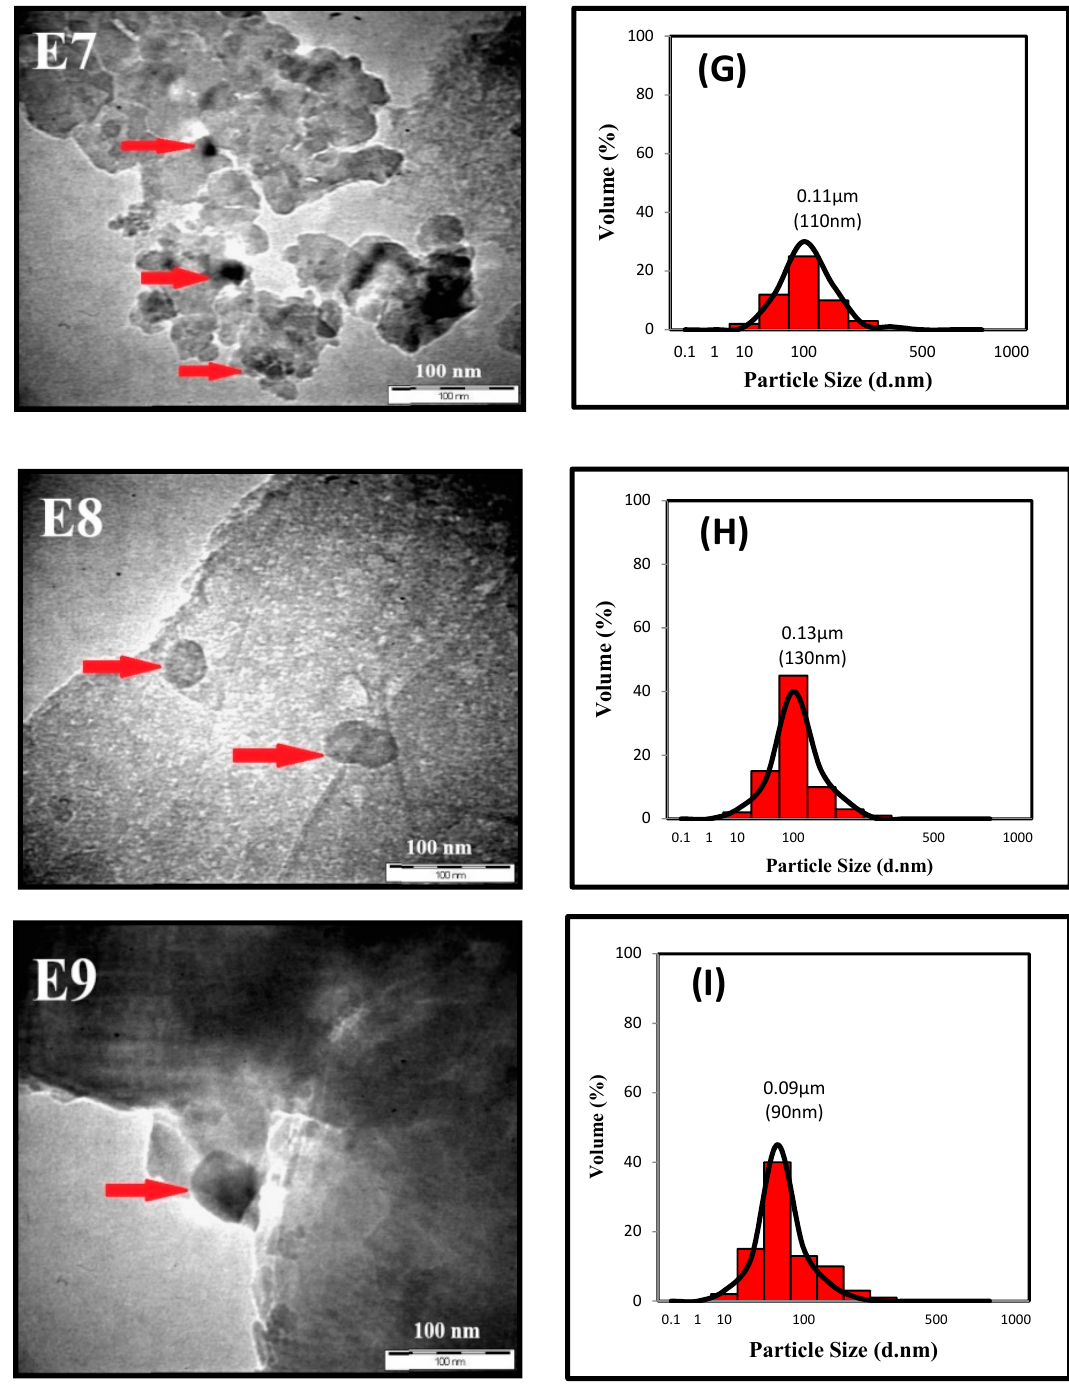
Figure 4. TEM image (E4–E6) and POA nanoparticle distribution ( D – F ) from the experiment four, five, and six of the Taguchi optimization processes.